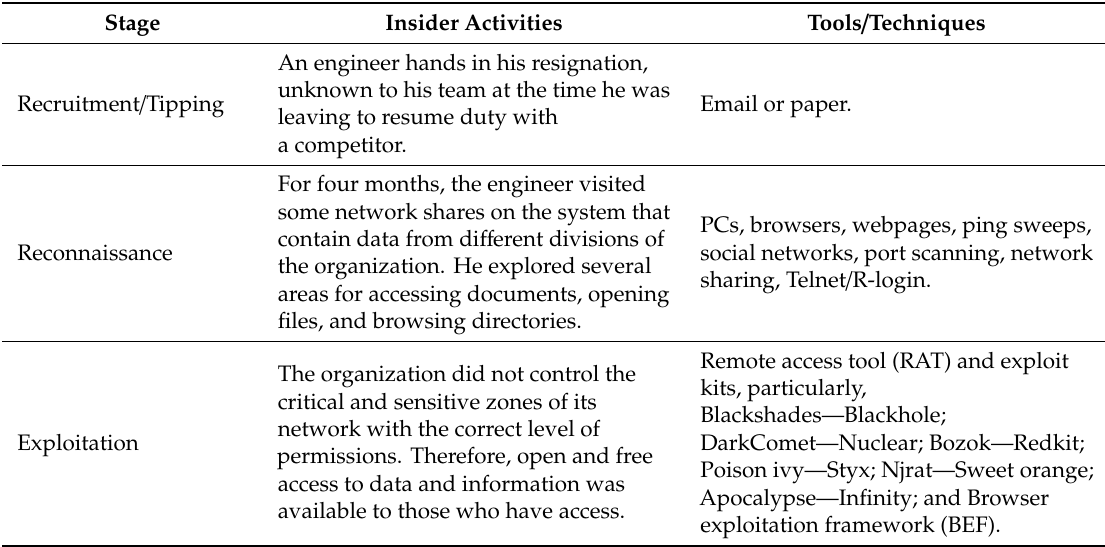
Table 1. Insider threat and kill chain